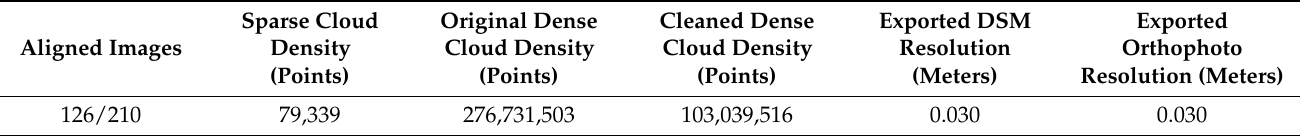
Table 1. Main outputs of the structure-from-motion process performed on unmanned aerial vehicle images.